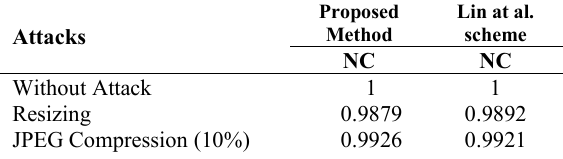
Table 2. The Comparison result of common